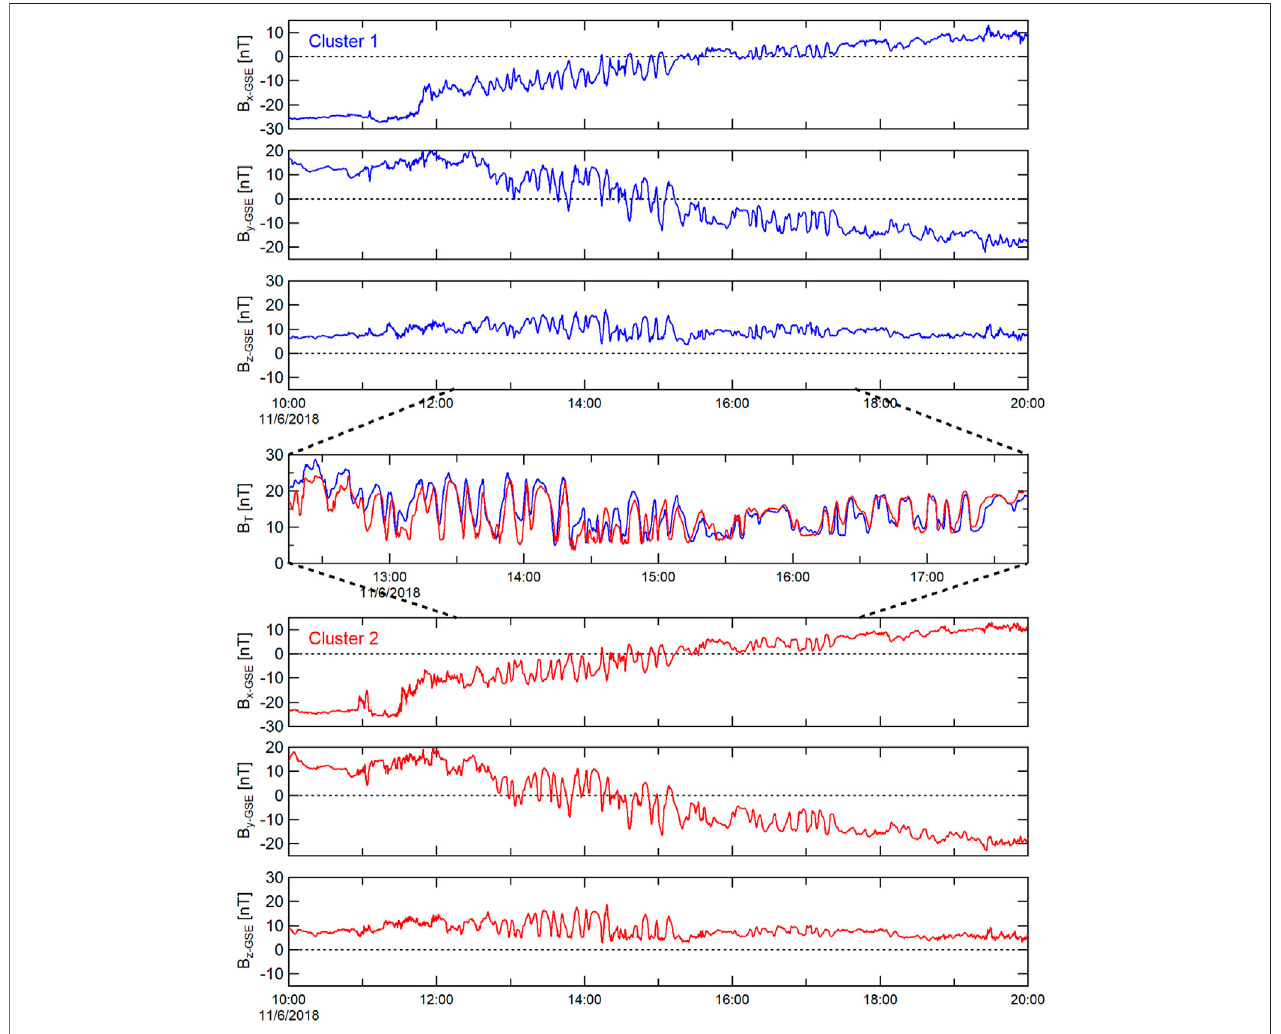
FIGURE 7 | Magnetic fi eld observations from Cluster 1 and Cluster 2, in GSE coordinates. Panel format is the same as that of Figure 6 .